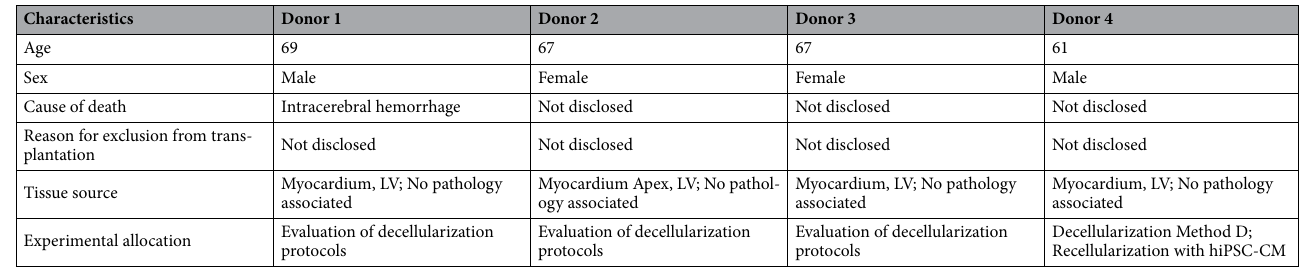
Table 1. Cardiac tissue donor data. LV left ventricle, hiPSC-CM human induced pluripotent